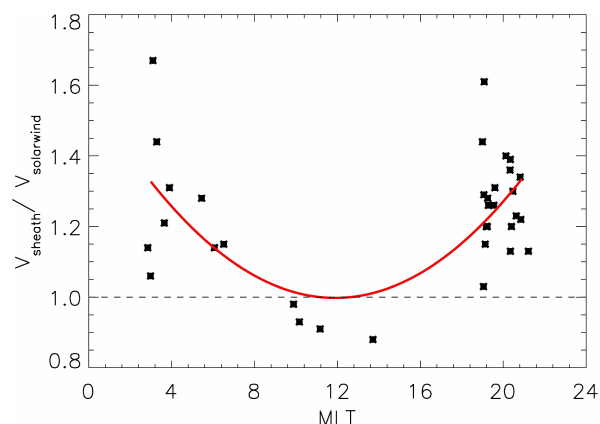
Fig. 5. A scatter plot of the speed ratio versus X expressed as a fraction of the subsolar radius of curvature, L 0 , for two ranges of M A . The black line is for 4 <M A < 6, while the red line is for a much higher solar wind M A , namely 12 <M A , where the pressure gradient force is more dominant.